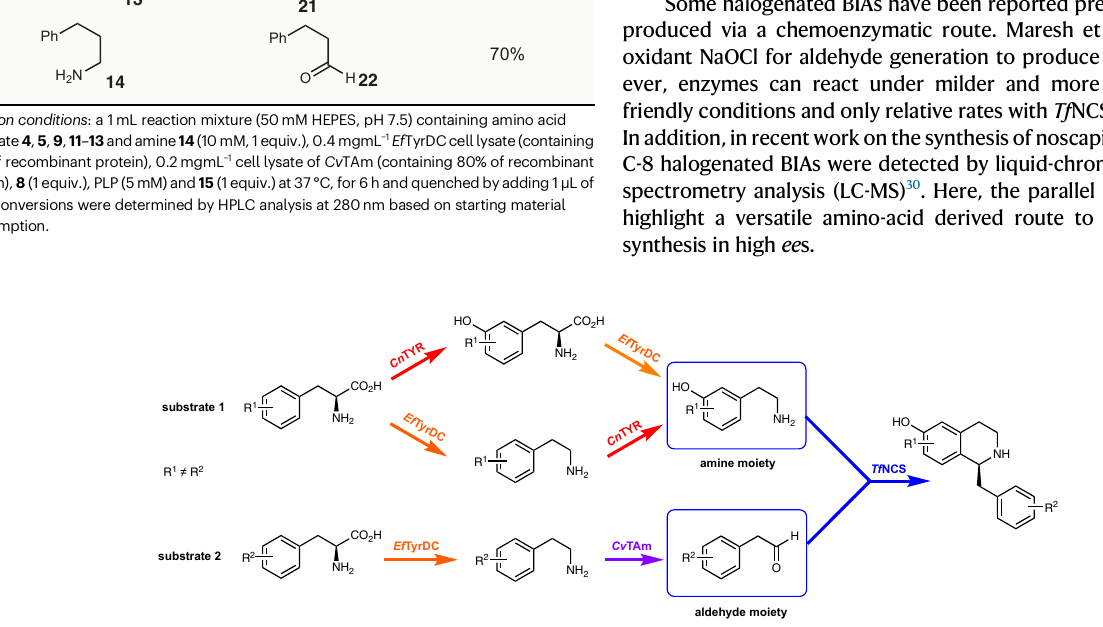
wasconvertedintothealdehydemoietybya Ef TyrDC- Cv TAmcascade.Non-natural BIAs were then synthesised using Tf